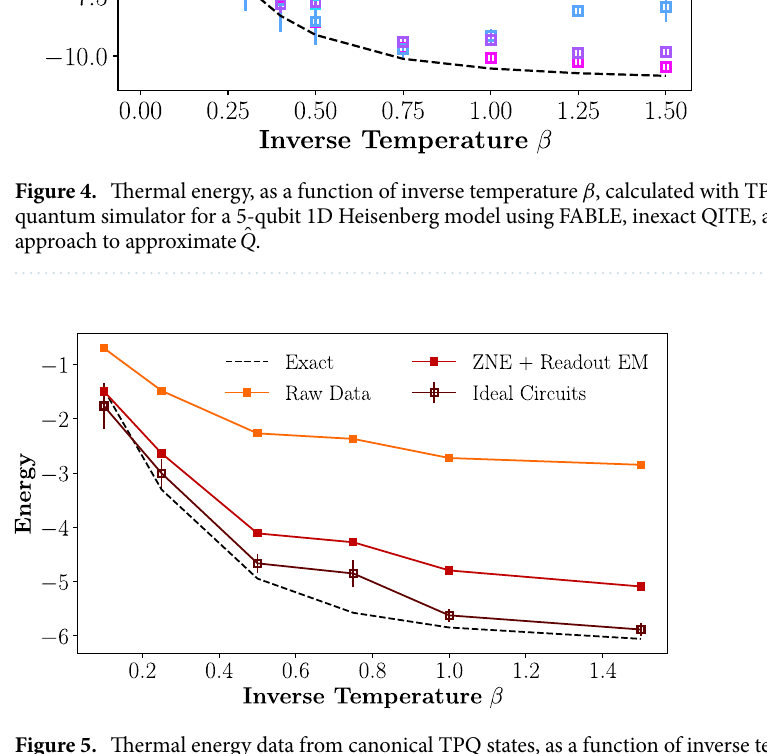
_ brooklyn” quantum